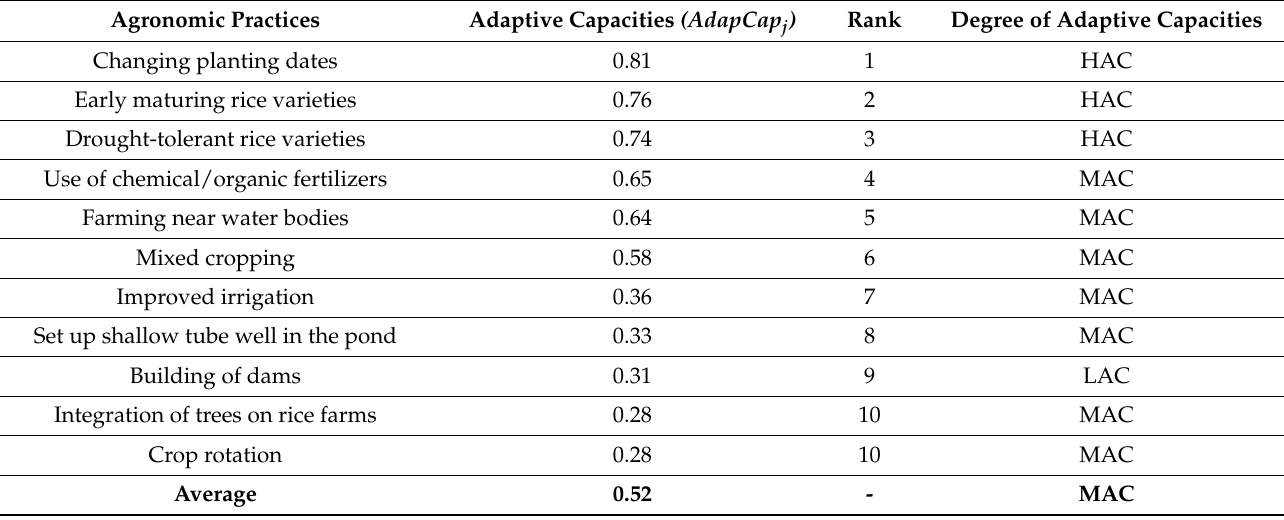
Table 4. Degree of capacities of adaptation of